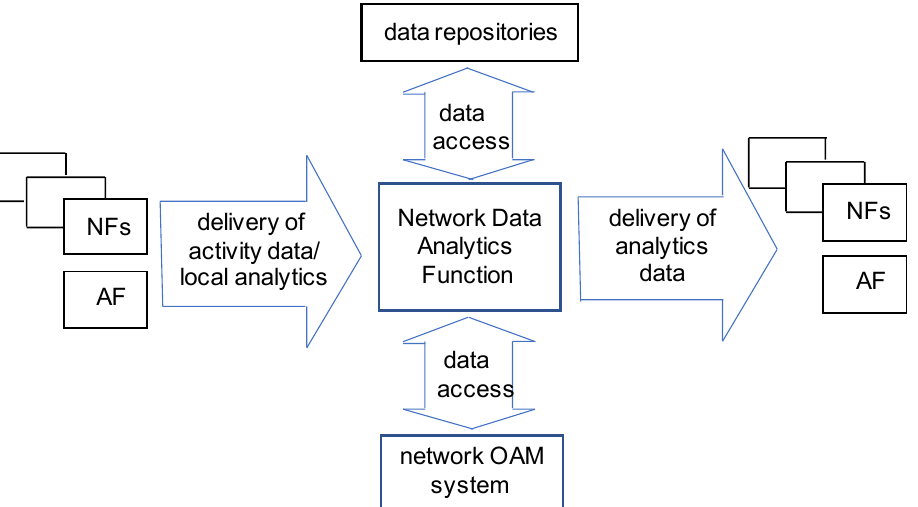
Figure 2. A Network Data Analytics Function (NWDAF)-based framework for 5G network automatic